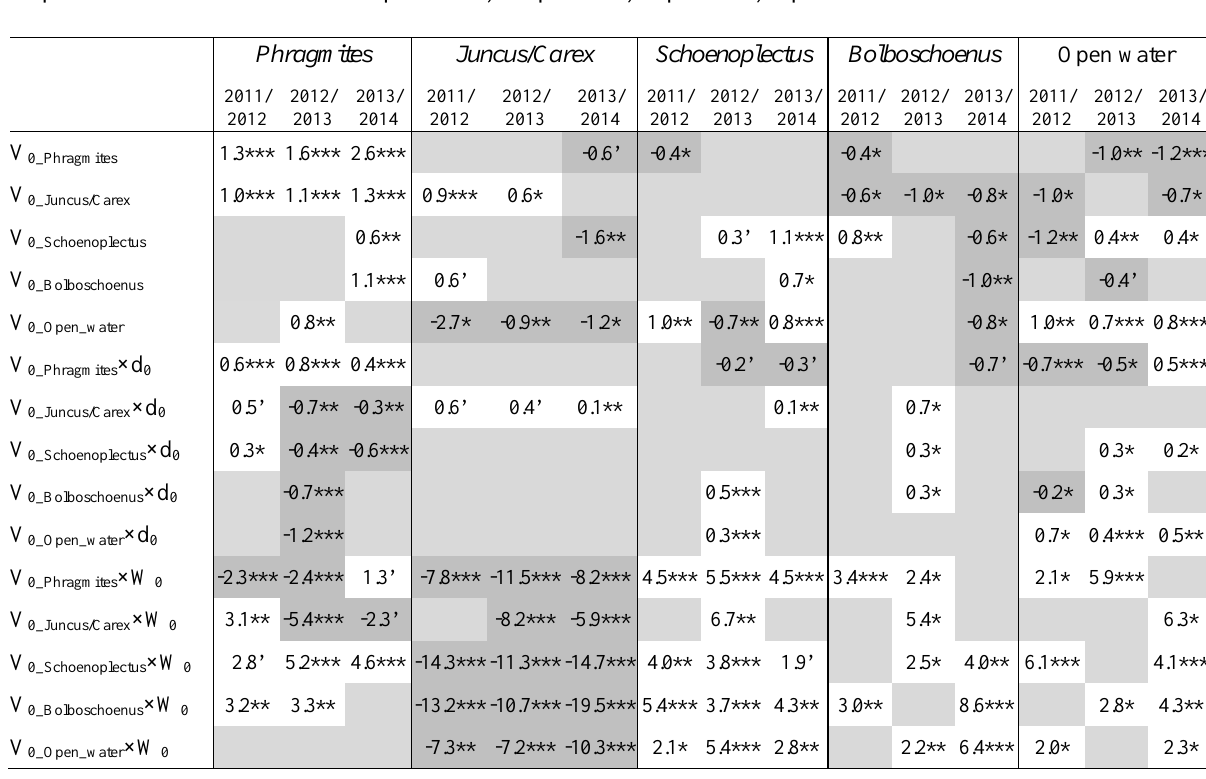
Table 4. Logit regression coefficients for multinomial succession models for year-to-year vegetation change. Coefficients are shown with respect to symmetric side constraints (Zahid & Tutz 2009). Significant positive values (white background) indicate a positive effect of the respective predictors on the odds ratio, negative values (dark grey) indicate a negative effect. V 0 : Vegetation at sample point in previous season, d 0 : distance to nearest different vegetation unit in previous season, W 0 : Water level in previous vegetation period. Validation accuracies are 56 %, 57 %, 65 %; McFadden’s pseudo R² values are 0.32, 0.37, 0.46 for